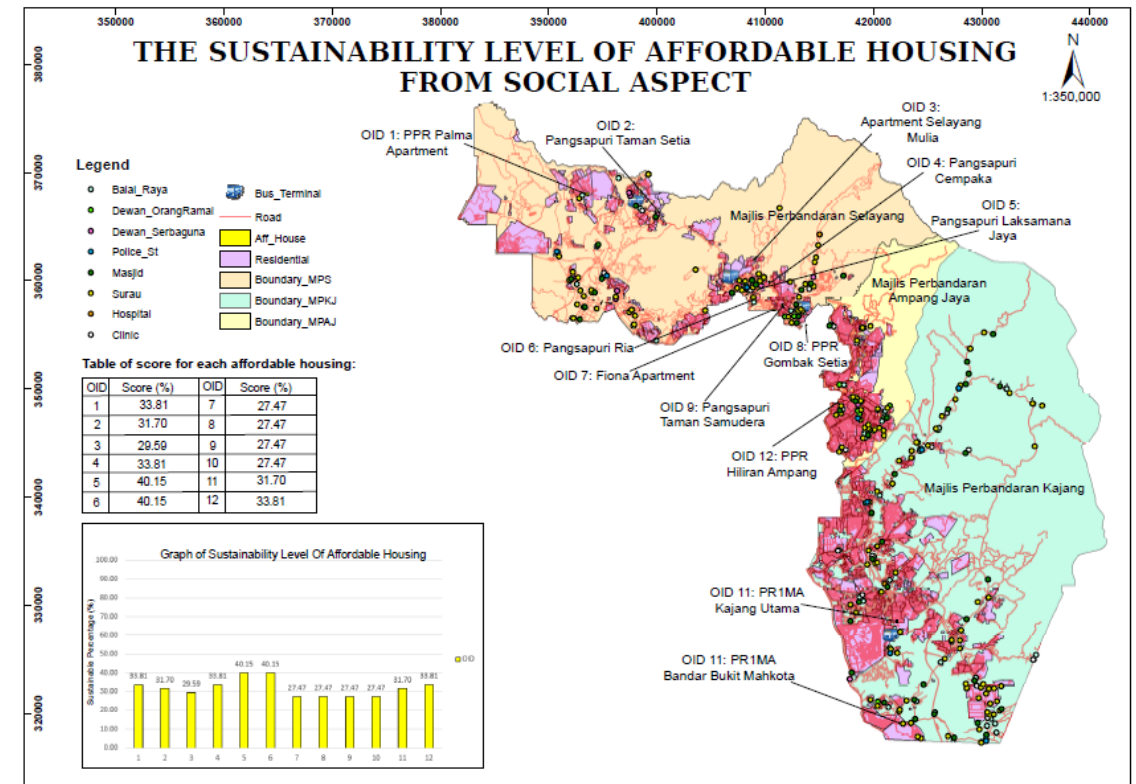
Figure 1: The sustainability level of affordable housing from social aspect in Selayang, Gombak and Kajang